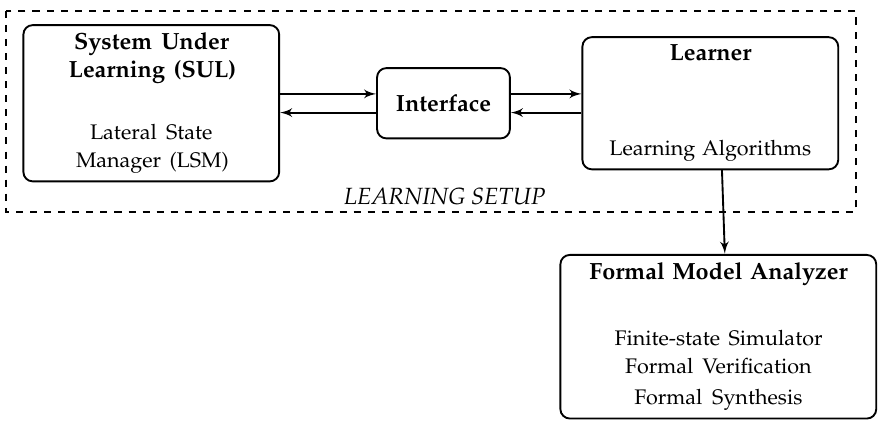
Figure 10. Overview of the learning